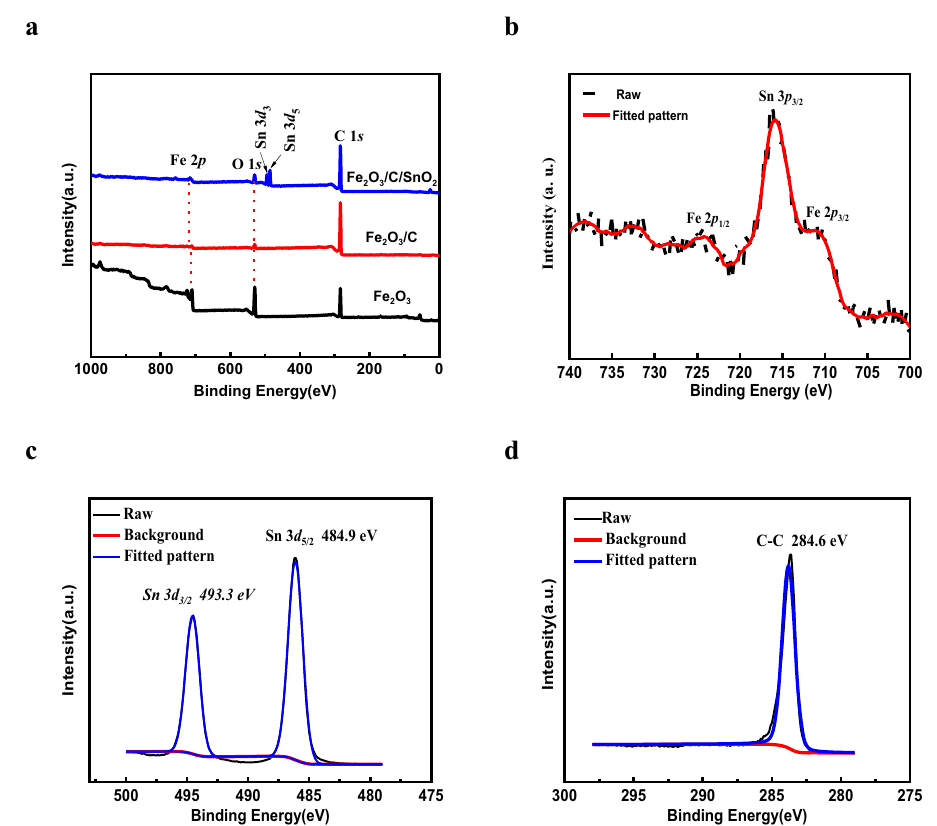
Fig. 3 XPS spectrum. a The XPS of Fe 2 O 3 , Fe 2 O 3 /C (the mass ratio of 3:1), Fe 2 O 3 /C@SnO 2 (the mass ratio of 3:1:4), b high-resolution curves of c Fe, Sn, and d